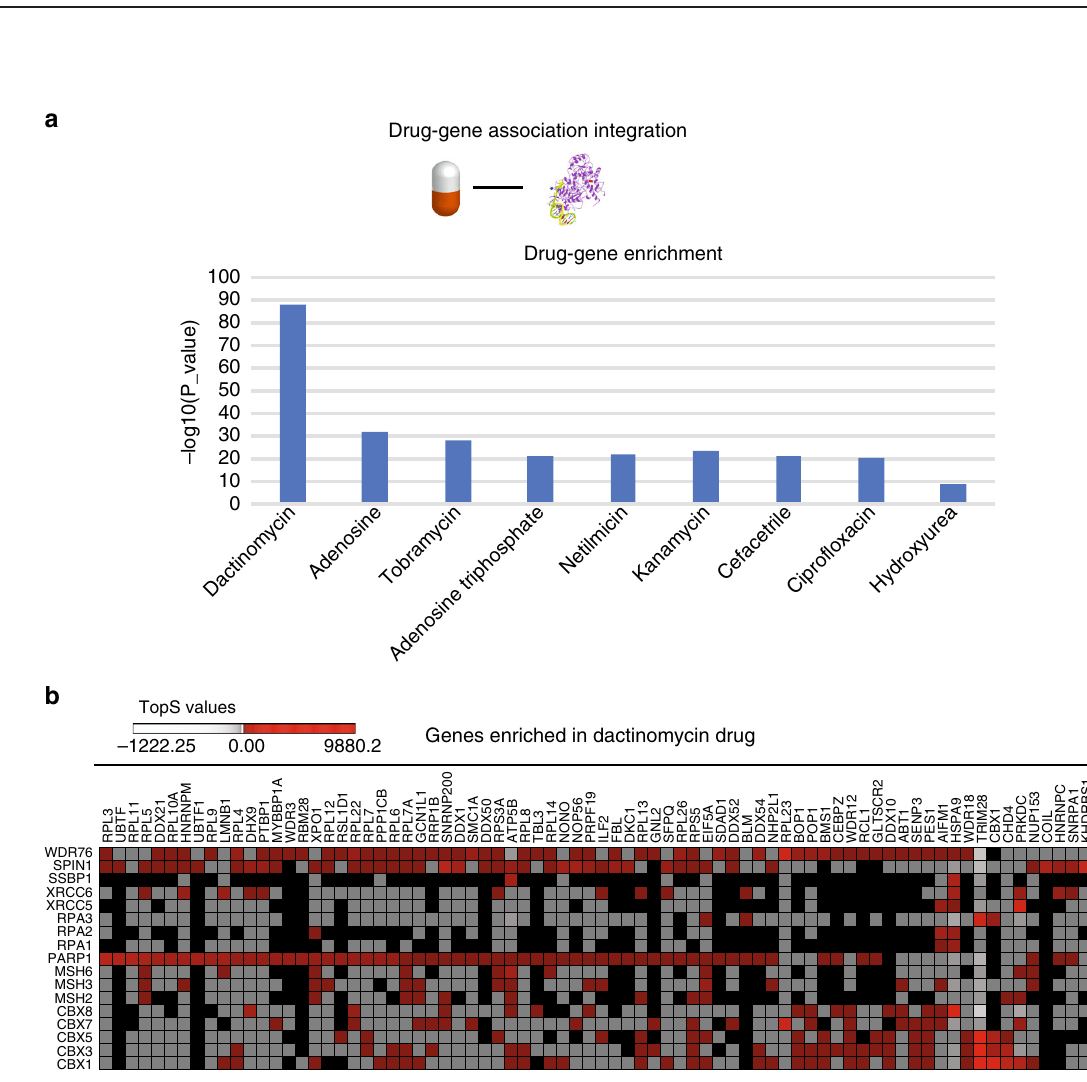
Fig. 4 Enrichment of drug targets in the human DNA repair network. a The proteins detected and scored in our human DNA repair dataset were enriched in nine gene − drug classes. The enriched classes were obtained using WebGestalt database 31 . b Proteins/genes enriched in the dactinomycin set are represented. The red color represent high TopS values. TopS topological scoring